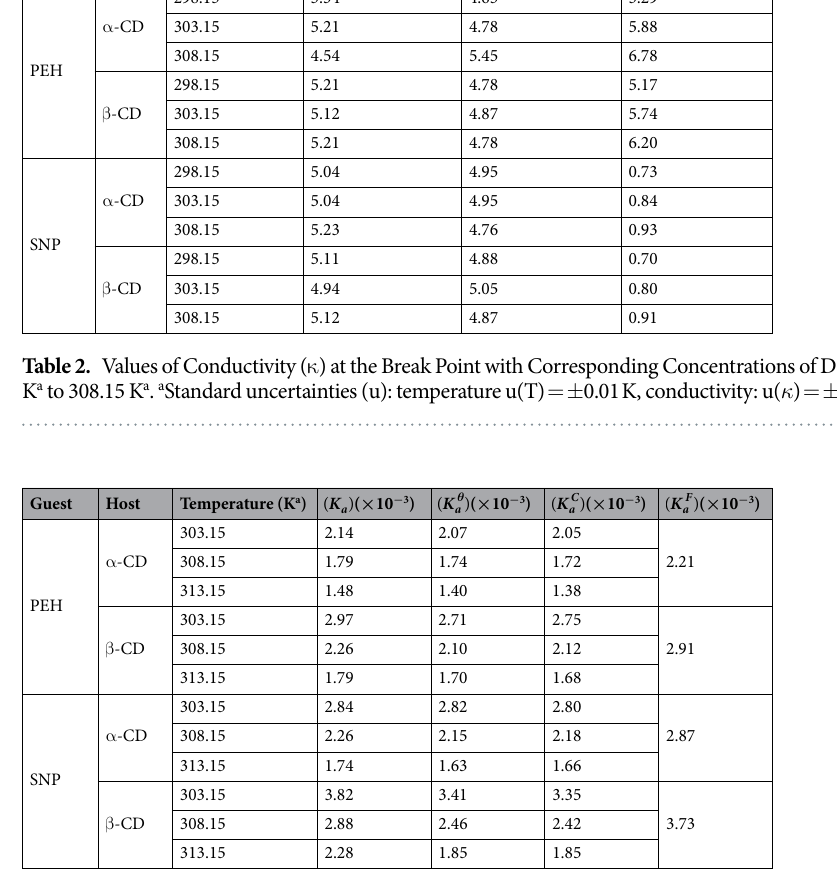
Table 3. Association Constant obtained from Benesi-Hildebrand method ( K a ), Association Constant obtained , Association Constant obtained from Program based mathematical from the Nonlinear Program θ K ( ) a calculation of non-linear changes in the conductivity data K ( ) aC , Association Constant obtained from Benesi- Hildebrand equation, using the spectrofluorometric data K ( ) aF at 298.15 to 308.15 K a . a Standard uncertainty in temperature, u, are u(T) = ± 0.01 K a